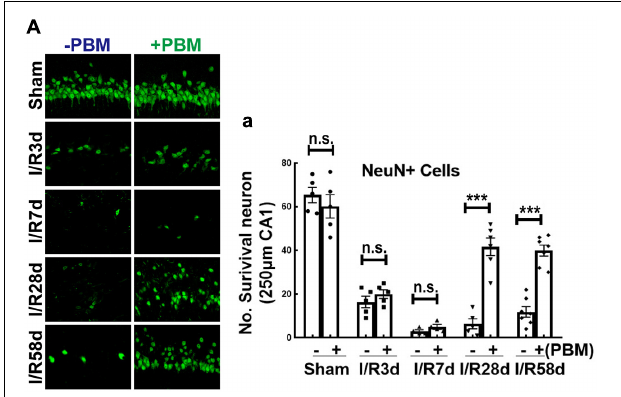
FIGURE 1 | The effect of photobiomodulation (PBM) treatment on neuronal survival in the hippocampal CA1 region following global cerebral ischemia (GCI). (A) Representative images of NeuN staining (green, reflecting surviving neurons) in the indicated groups and quantification of NeuN+ cells (A-a) in the 250 µ m hippocampal CA1 region, showing the beneficial effects of PBM on the 28th and 58th days but not on the 3rd or 7th day after GCI ( n = 5–7 in each group). *** P < 0.001 between the two groups. n.s., no significant difference. Scale bar: 50 µ m; magnification: 40 ×